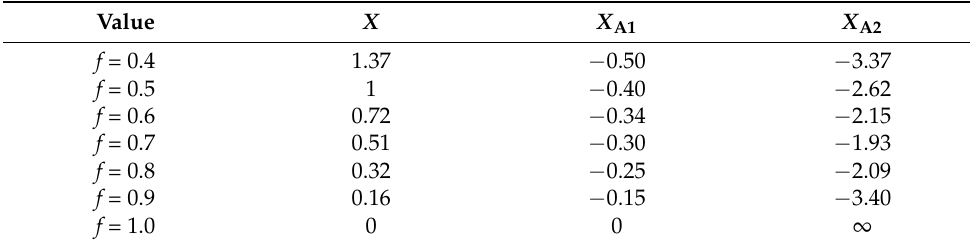
Table 1. The values of X and X A at representative